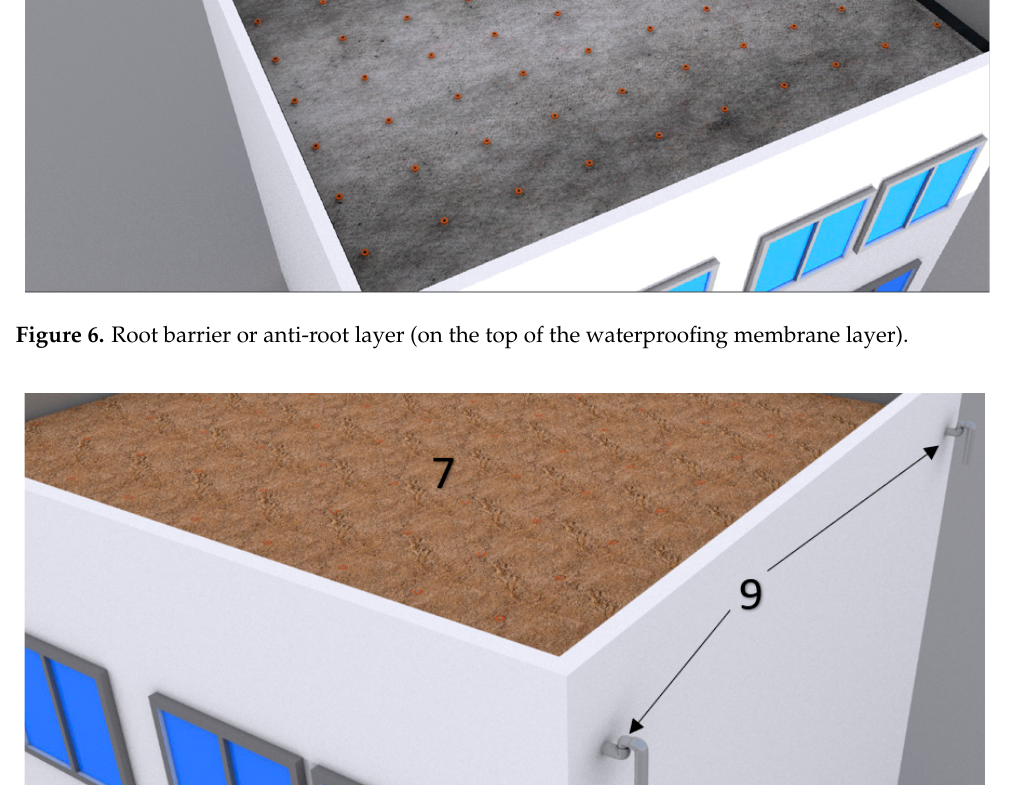
Figure 8. The layers in the novel green roof. Figure 9. Details of all layers. (1) Polystyrene foam; (2) PVC tube; (3) multilayer filter; (4) 1 cm of polystyrene foam; (5) waterproofing membrane; (6) root barrier layer; (7) soil media; (8) drain filters.